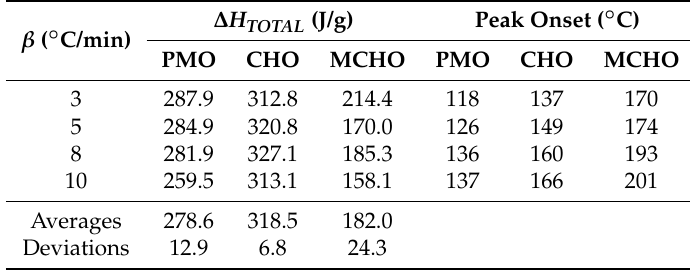
Figure 3. DSC thermograms of PMO, CHO and MCHO at 5 °C/min. Table 1. Enthalpies of reaction and exothermic peak onsets as a function of the heating rates, for PMO, CHO and MCHO.